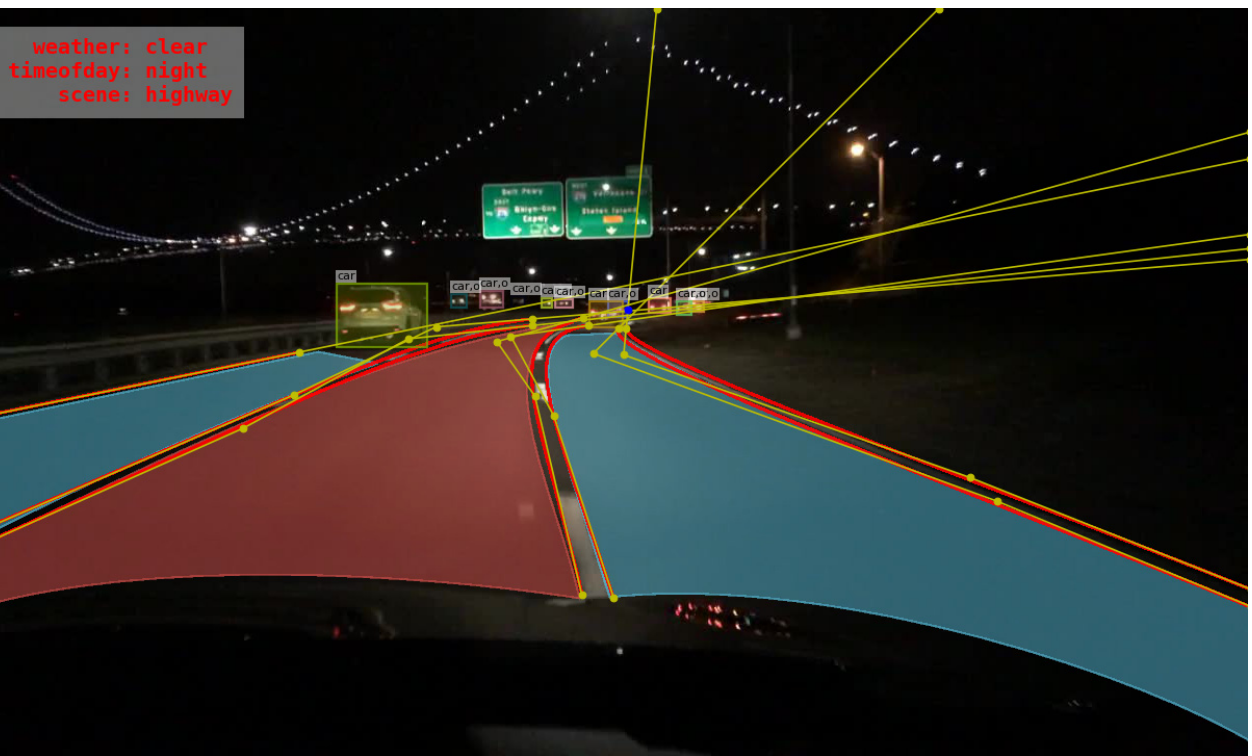
Figure 11. Illustration of lane lines labelling extension.